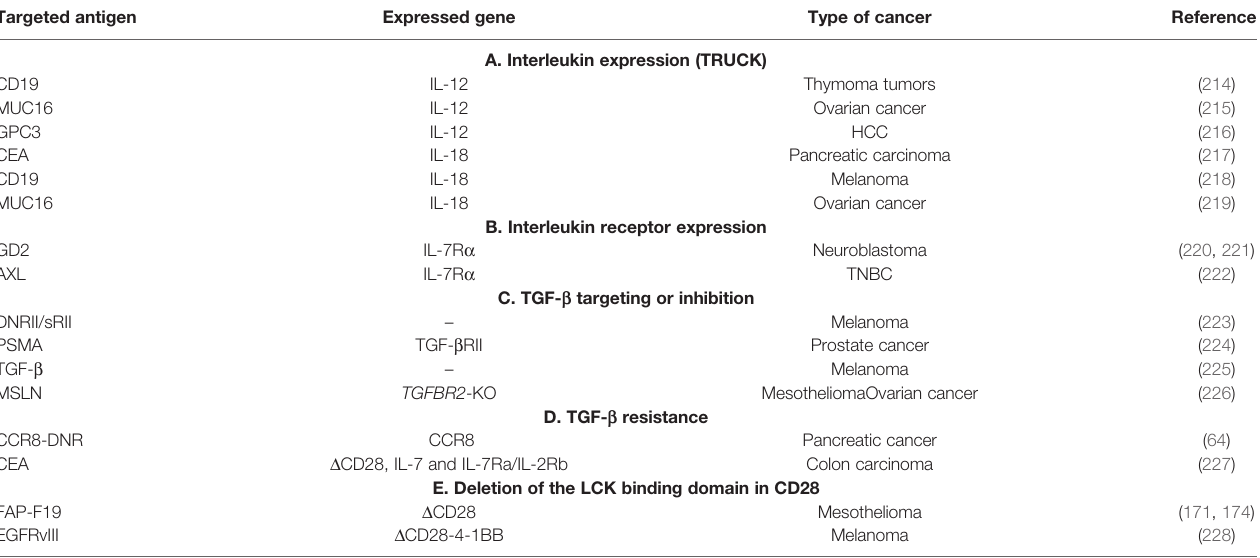
TABLE 6 | Summary of preclinical studies on CAR-T cells to overcome the immunosuppressive effect of Tregs. Targeted